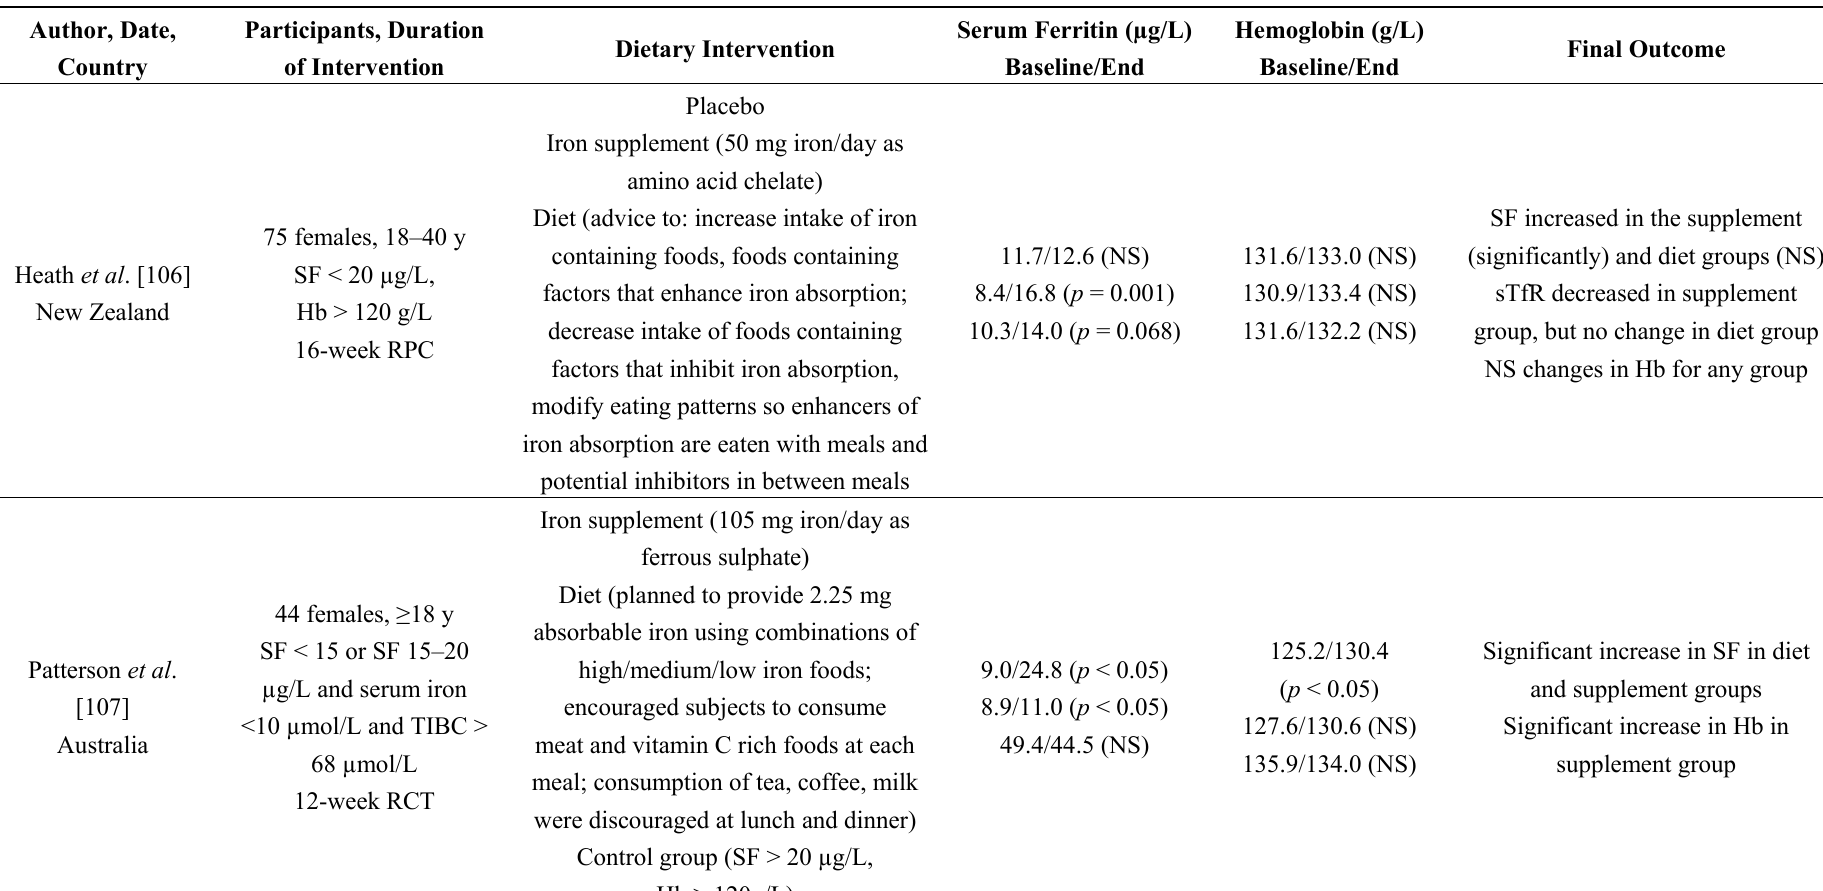
Table 6. Interventions using combined dietary approaches to improve iron status in young